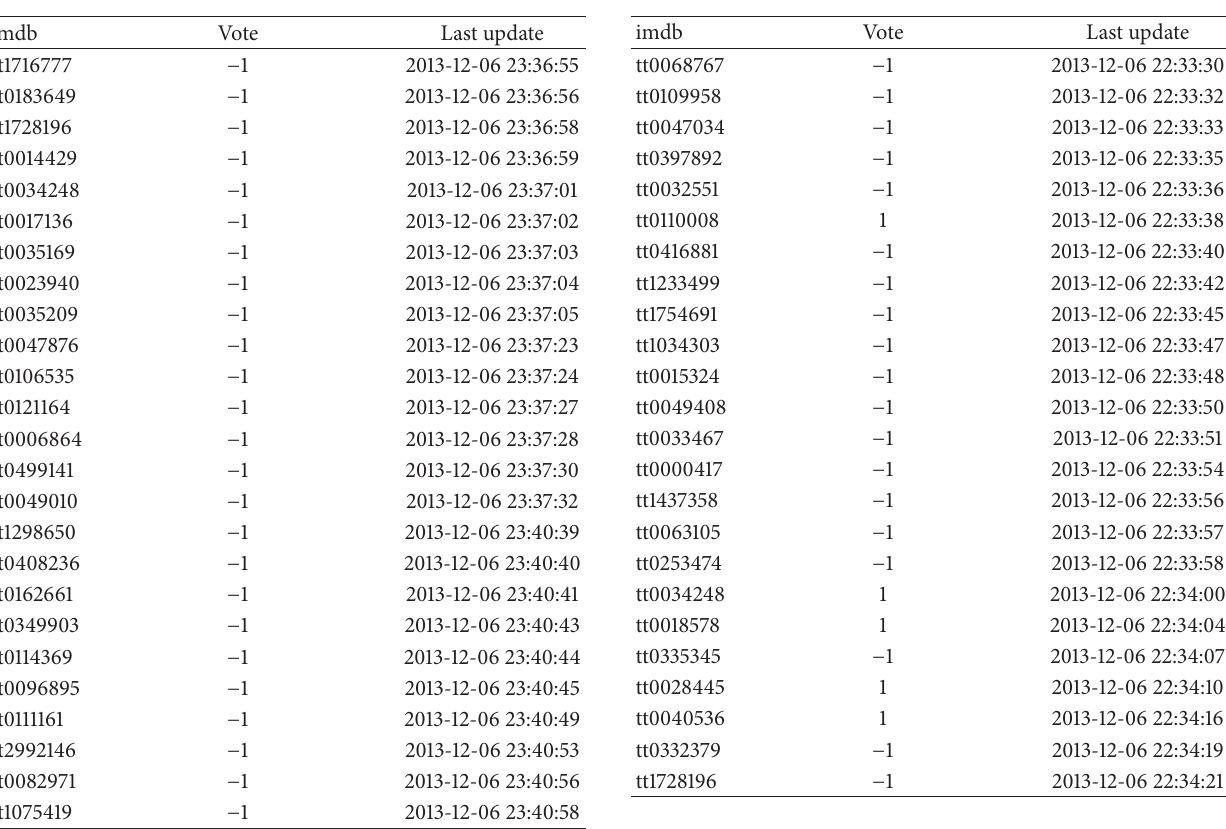
Table 3: Example of all negative votes. Table 4: Example of nonzero